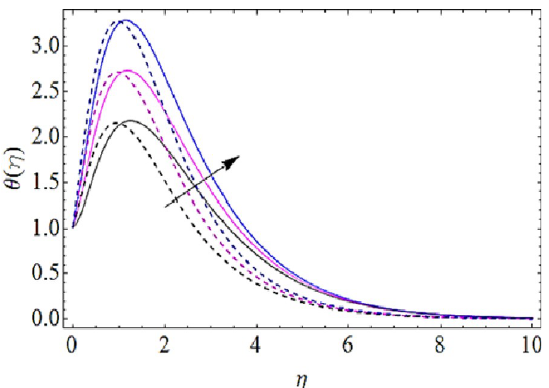
Fig 10. Thermal characteristics for different values of thermophoresis